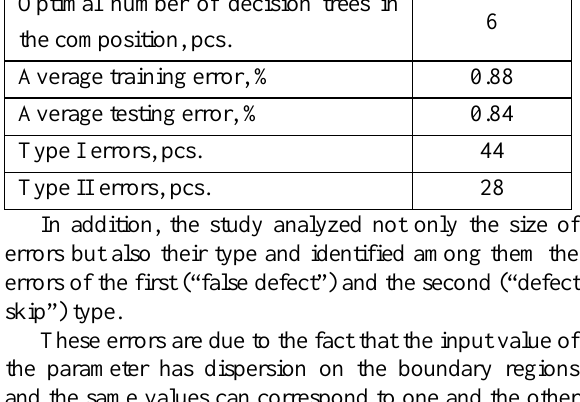
Table 1. The main characteristics of the developed model Сharacteristic Values The number of pairs in the training 446 sample, pcs. Optimal depth of decision trees,